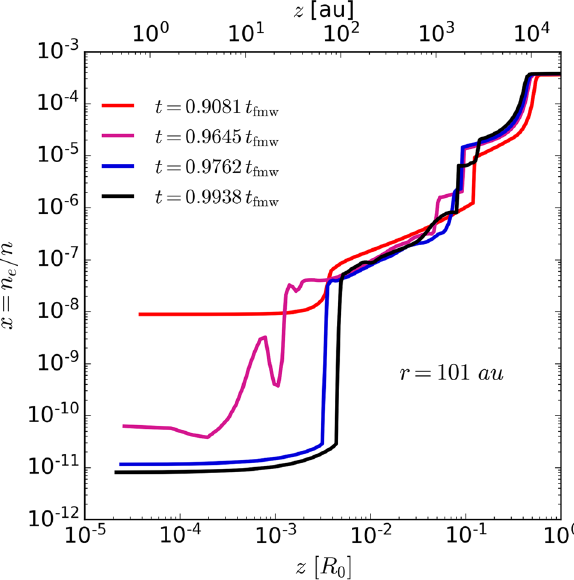
Figure 4: Pro fi les of the ionization fraction, x , along the z - direction at r 100 = au in run II at several times corresponding to Figure 2 ( e, f, g, h )